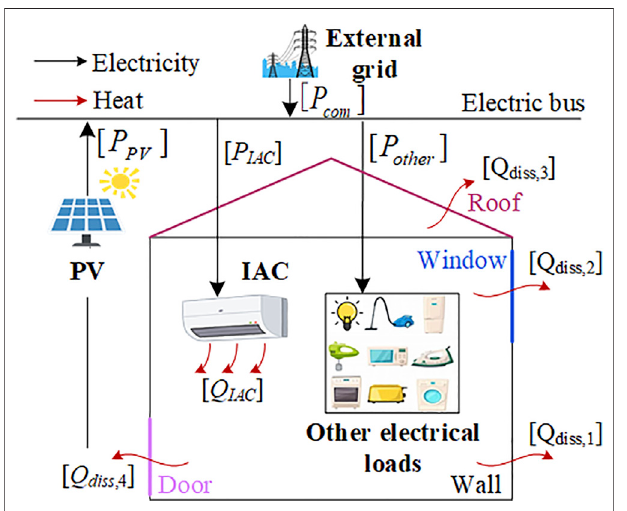
FIGURE 1 | Schematic diagram of the typical PV-BES.